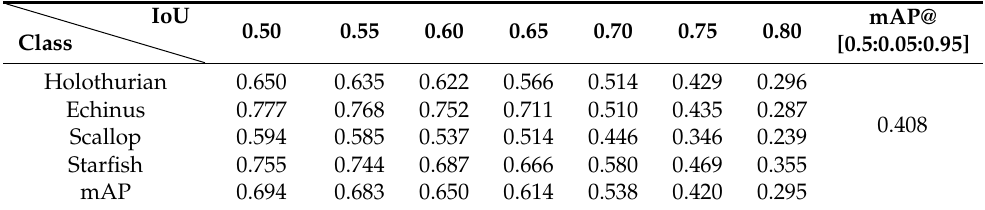
Table 2. Mean average precision of the underwater data set at different IoU thresholds of the proposed